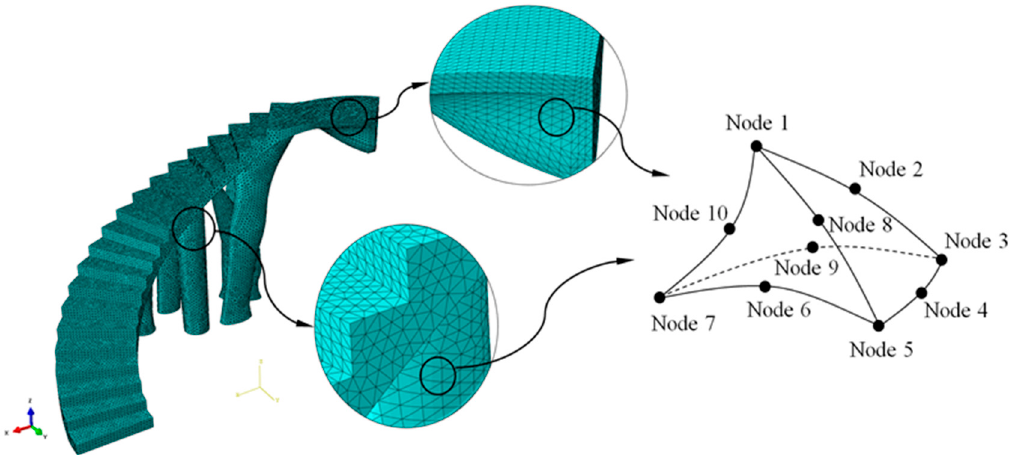
Figure 23. Mesh generated for the mechanical simulation, the BIM building element E 1 .